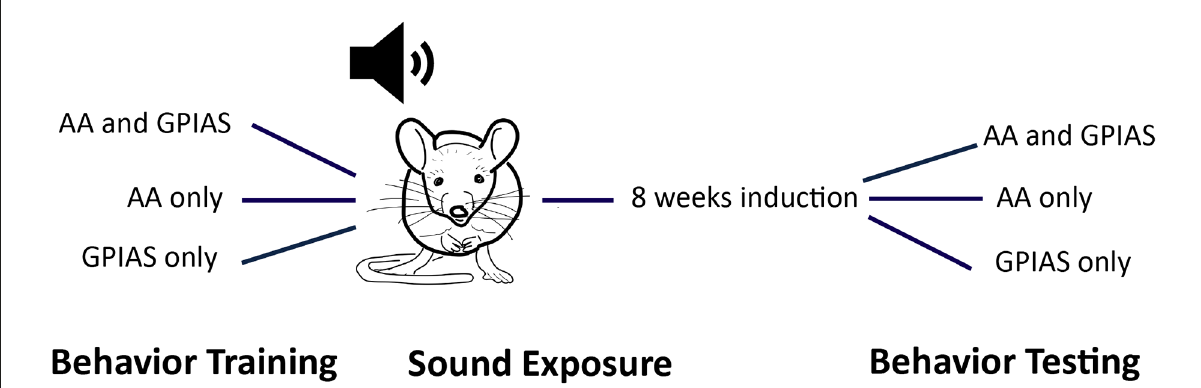
FIGURE1 Behavioral training paradigm. Animals were trained either in active avoidance (AA) or gap-induced pre-pulse inhibition of acoustic startle (GPIAS) or both tests at once. Once training was finished, animals were sound exposed to generate tinnitus (113 or 116 dB 16 kHz 2 kHz wide noise band). Most were exposed with 113 dB as 116 dB caused an increase in dropped animals due to hearing loss (need number here). After 4–8 weeks to allow for tinnitus induction, mice were assessed in the tests that they were trained in before sound overexposure. Most animals that were trained in AA PRE were also trained in GPIAS post as the analysis did not require PRE data. However, it was impossible to test GPIAS PRE animals in AA post due to the need for